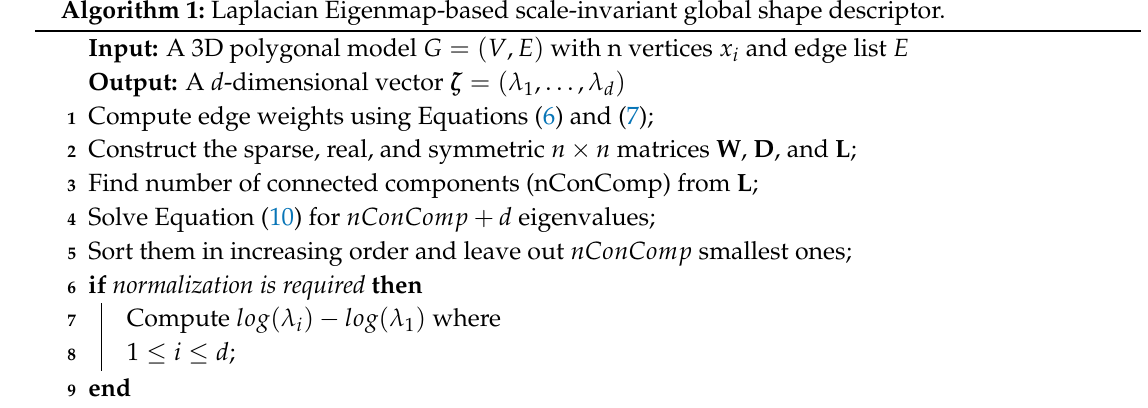
Algorithm 1: Laplacian Eigenmap-based scale-invariant global shape